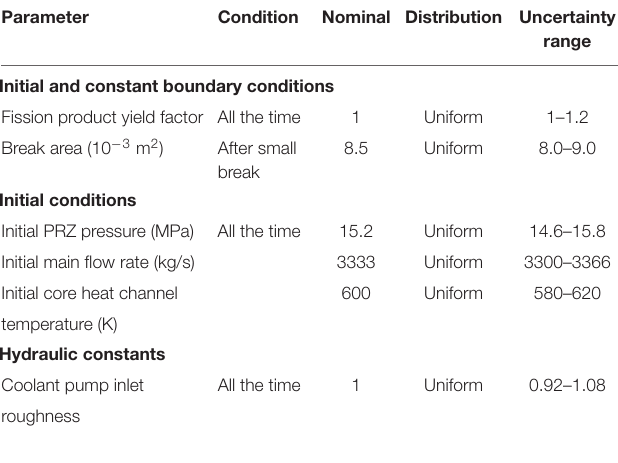
TABLE 4 | Input parameters for uncertainty analysis of the improved BEPU